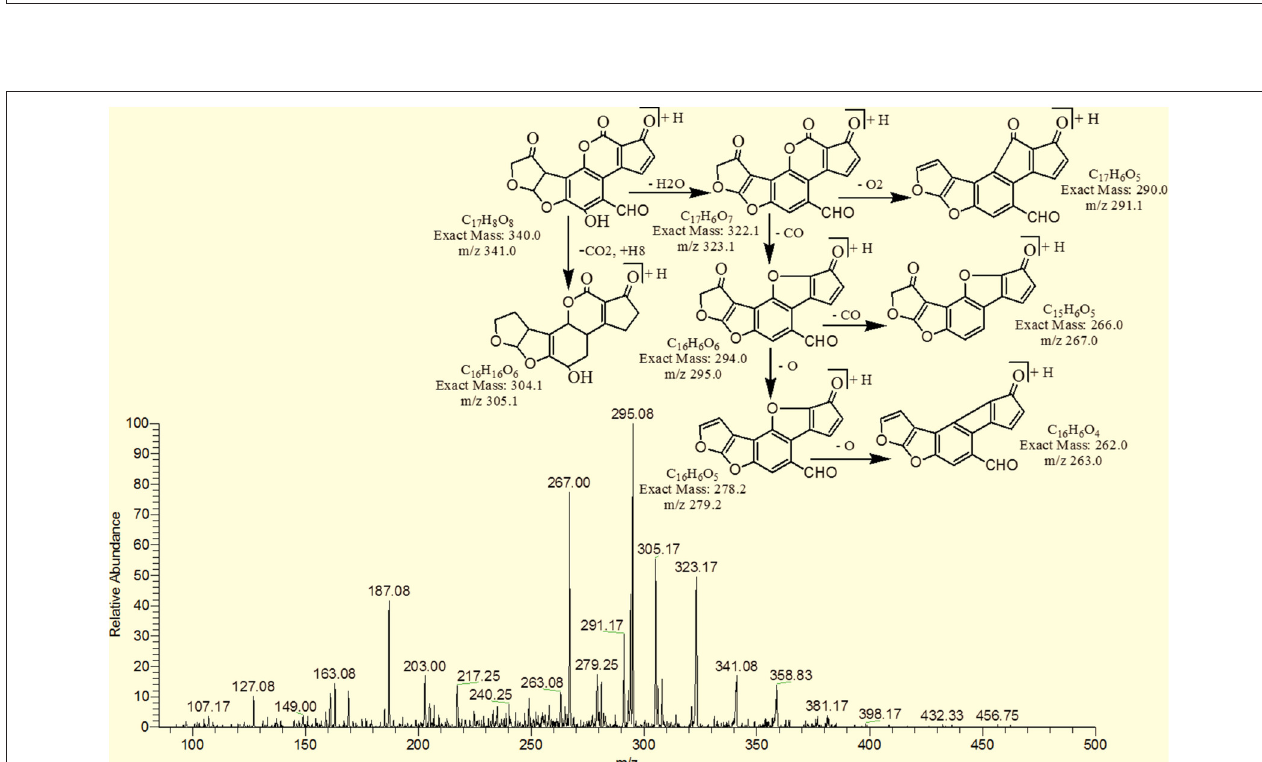
FIGURE 9 | MS/MS spectra and fragmentation pathway of degradation product with 341.08m/z.